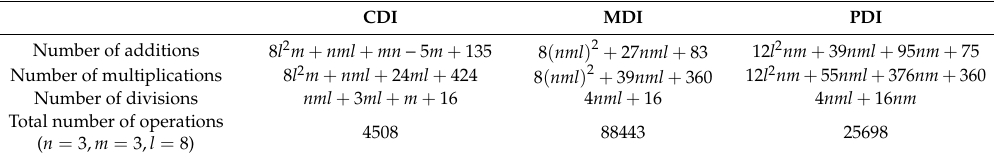
Table 4. Complexity of CDI, MDI, and